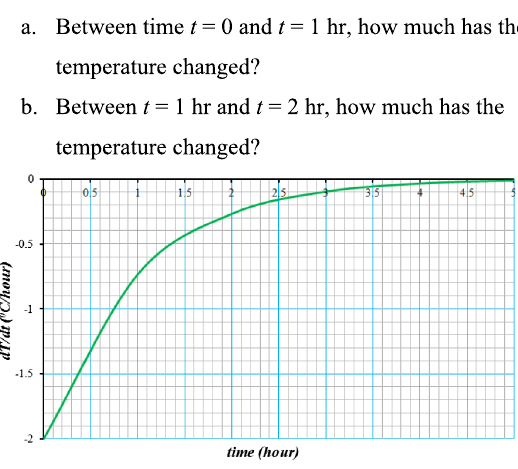
FIG. 2. The interview problem on